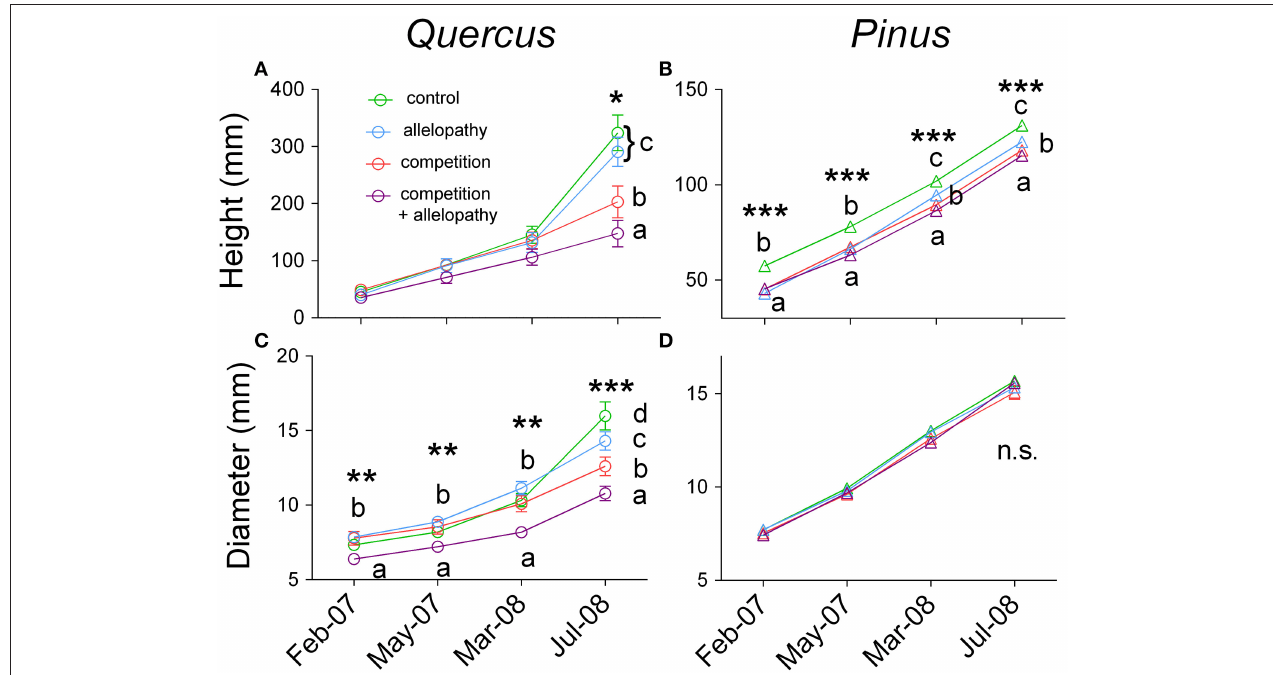
FIGURE 2 | Temporal effects of interference treatment on growth of both species. Height (A,B) and diameter growth (C,D) response in Quercus (A–C) and Pinus (B–D) across four dates of measurements (February and May 2007, March and July 2008) in Control (green lines and symbols), Allelopathy (blue lines and symbols), Competition (red lines and symbols), and Allelopathy + Competition (purple lines and symbols). Symbols represent means ± SD of 20 replicates. Different letters indicate a significant difference between treatments at P < 0.05 (*), P < 0.01 (**), and P < 0.001 ( *** ).